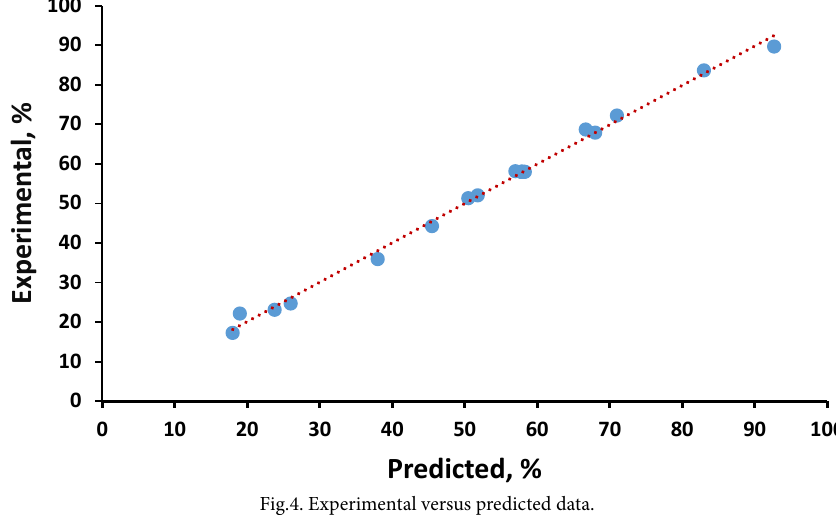
Fig.4. Experimental versus predicted data.